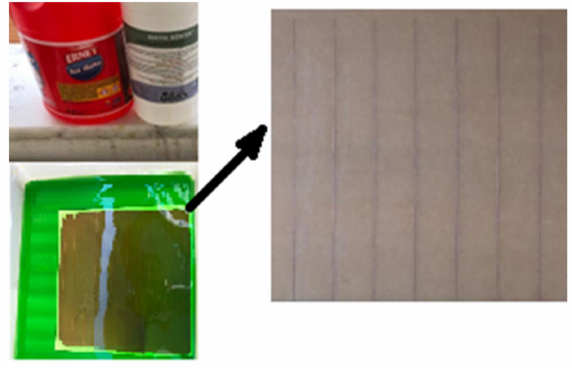
Figure 7. PCB implementation of model electrodes.